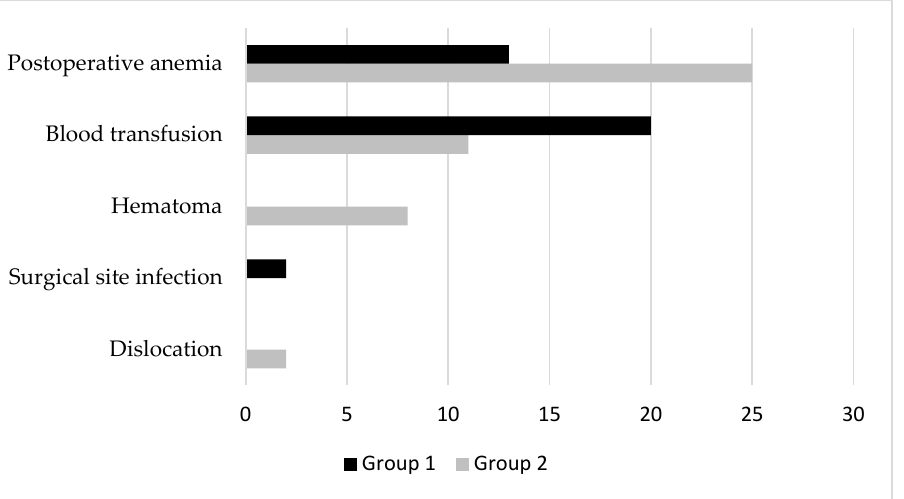
Figure 2. Perioperative local complications in the two groups.